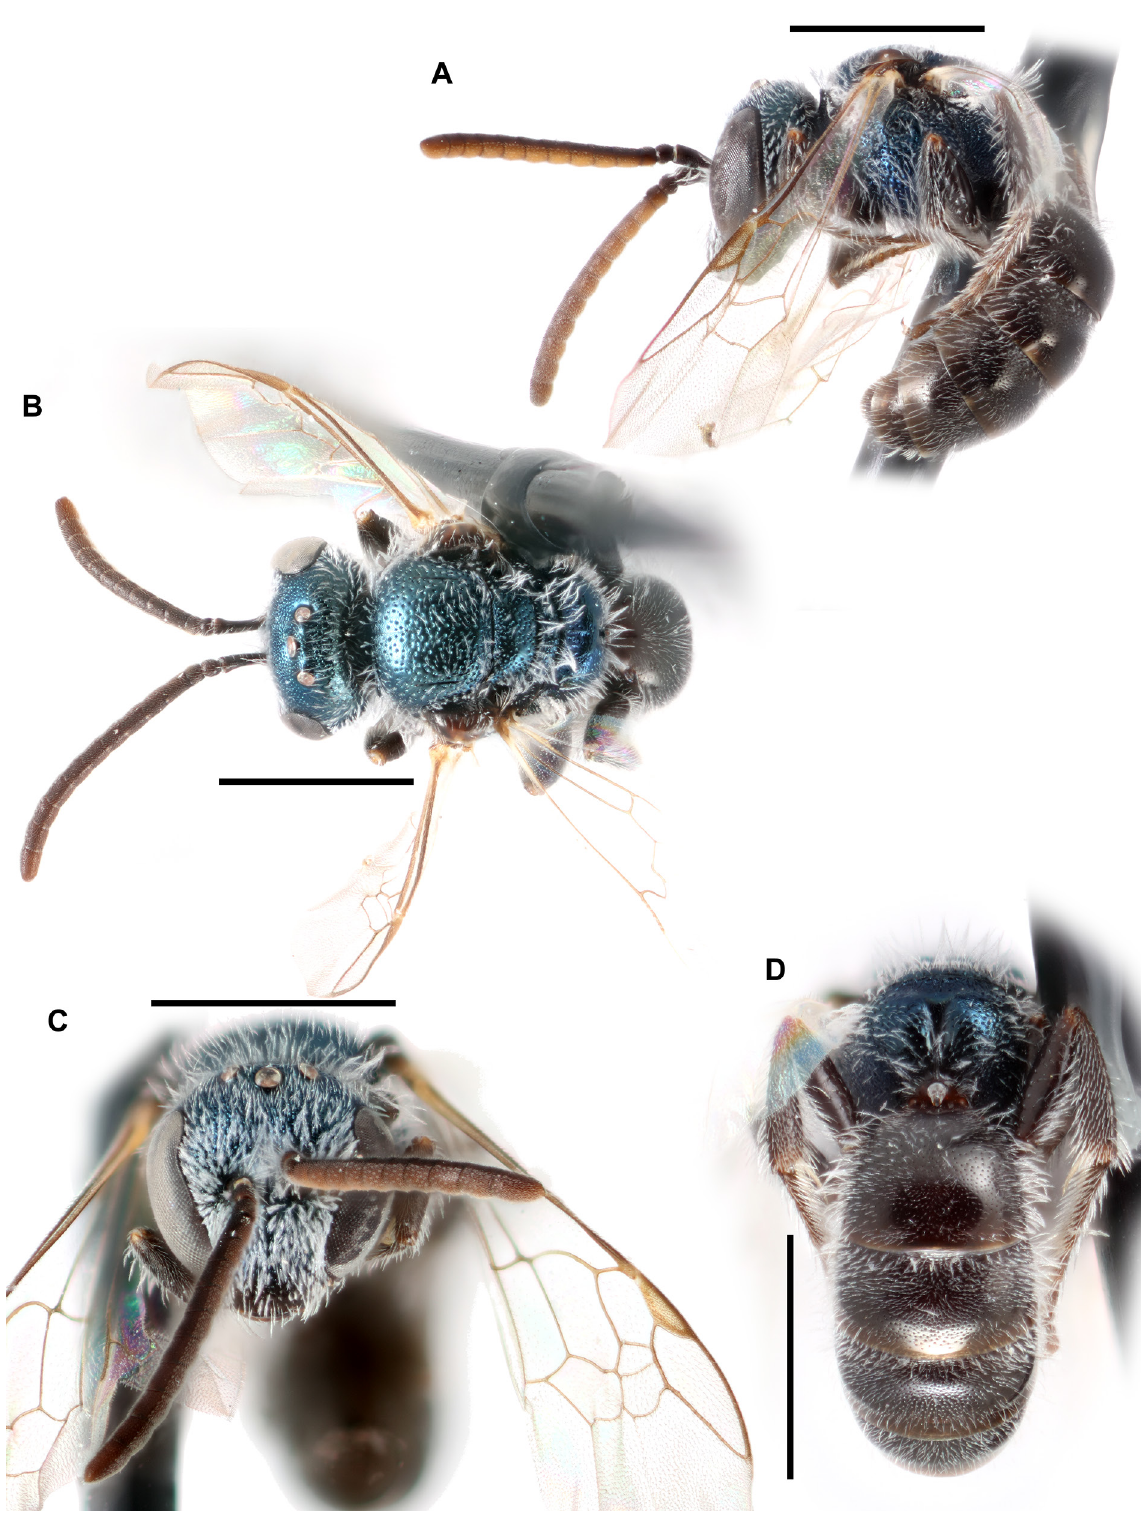
Fig. 49. Lasioglossum ( D .) profundum sp. nov., ♂ (CAVE19682). A . Lateral habitus. B . Dorsal habitus. C . Face. D . Metasoma and propodeum. Scale bars = 1